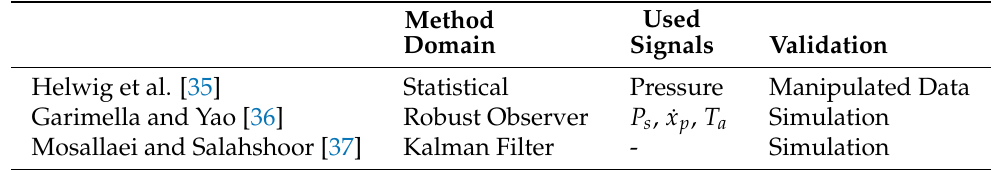
Table 4. Covered fault detection methods for sensor